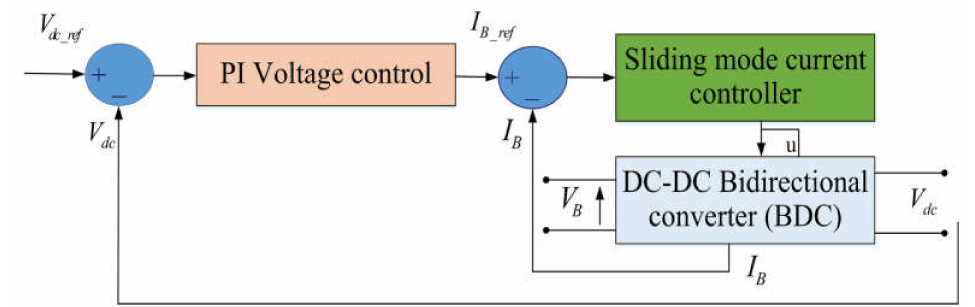
Figure 3. The control of the bidirectional converter (BDC).